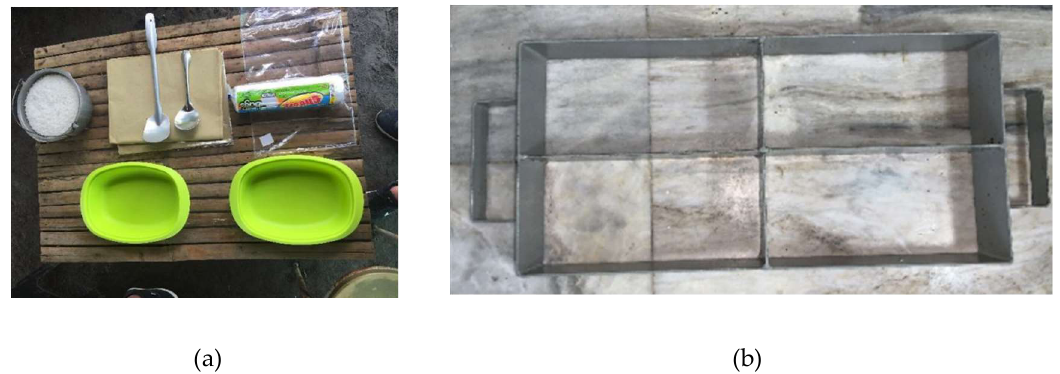
Figure 1. ( a ) Materials for mycelium substrate production; ( b ) brick molds used. Figure 1. (a) Materials for mycelium substrate production; (b) brick molds used.